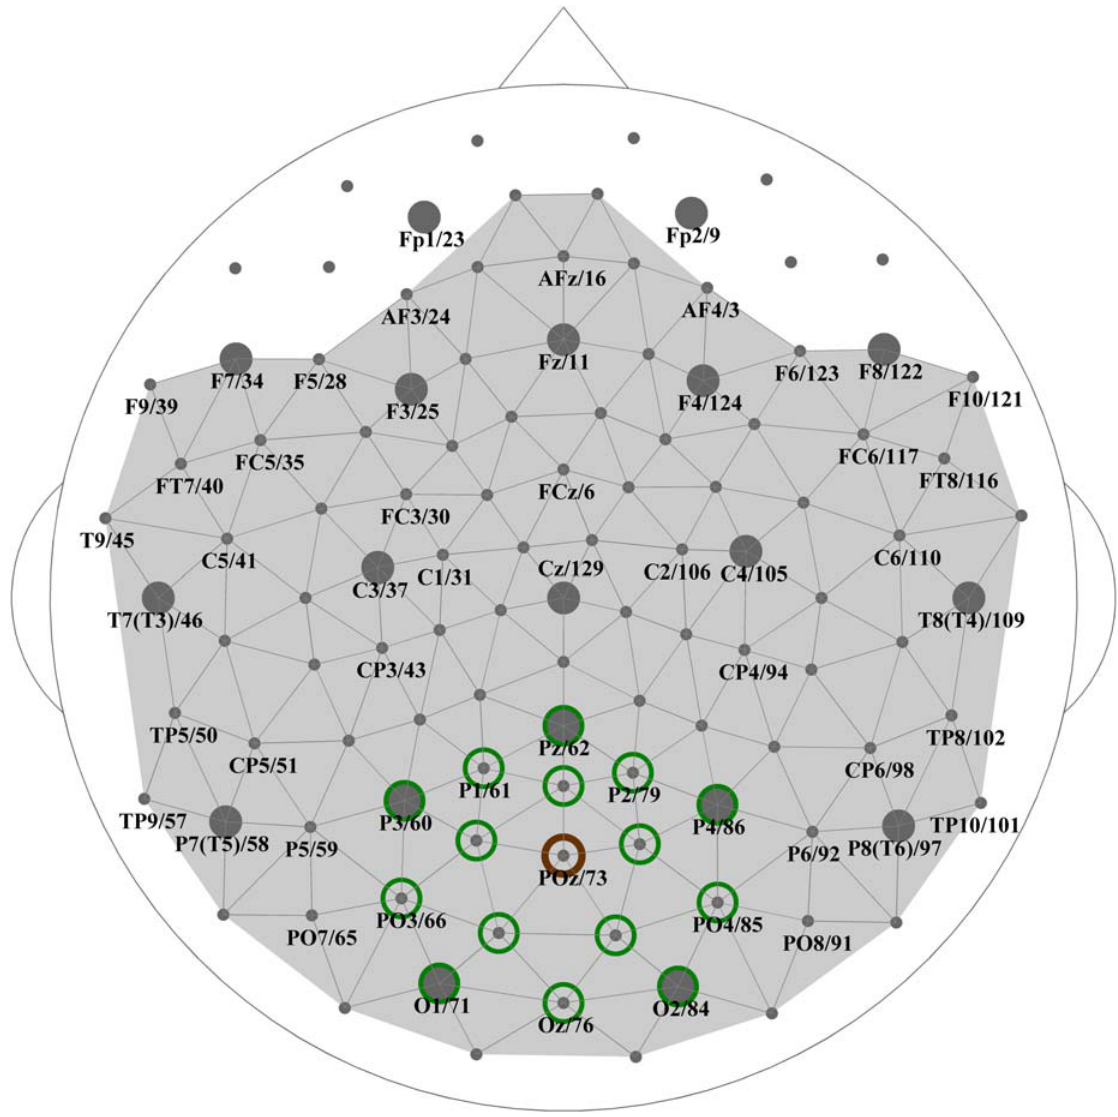
Figure 1. Head diagram of the EEG sensor positions and labeling. The diagram shows the correspondence between the high-density 129-channel Sensor Net (EGI, Inc.) and the International 10–10 System. The Sensor Net locations that match the positions of International 10–10 system are labeled. The 10–10 System names are followed by the numbers of the Sensor Net. The sensors corresponding to the 10–20 System (presented in all the maps hereafter) are in bold. The gray background highlights all the sensors included in the analyses. The sensor locations encircled in green exemplify the first and second neighborhoods for the sensor encircled in brown (sensor 73), i.e., the territory considered in the calculation of a single value of